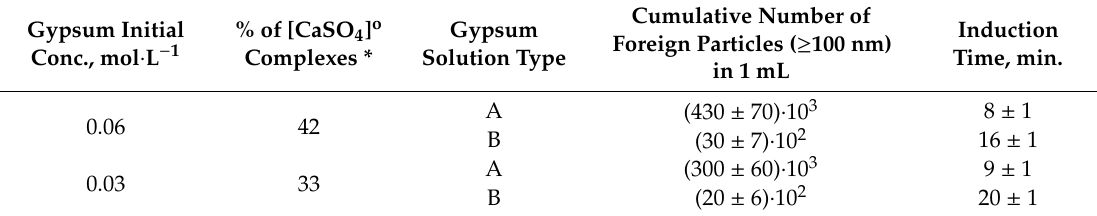
Table 4. The gypsum solutions characterization. Figure 1. Some consecutive measurements of a particle size distribution by intensity (left) and by number (right) in 0.10 mol ∙ L ‒ 1 Na 2 SO 4 stock solution (Sample type B), detected by DLS; the green (first scan), blue, pink, red, brown, swamp green, dark blue, dark brown (last scan) bands correspond to the sequential measurements (scans), taken with 30 s delay one after another.